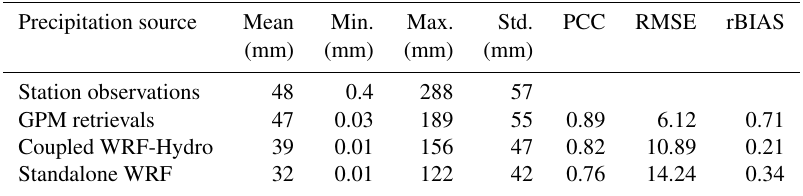
Figure 3. Accumulated storm rainfall over the UAE (d03) from station observations (a) , GPM 30min, 0.1 ◦ retrievals (b) , WRF (c) , and WRF–WRF-Hydro (d) . Table 2. Total storm rainfall statistical measures from collocated GPM retrievals, station observations, and simulations (WRF and WRF–